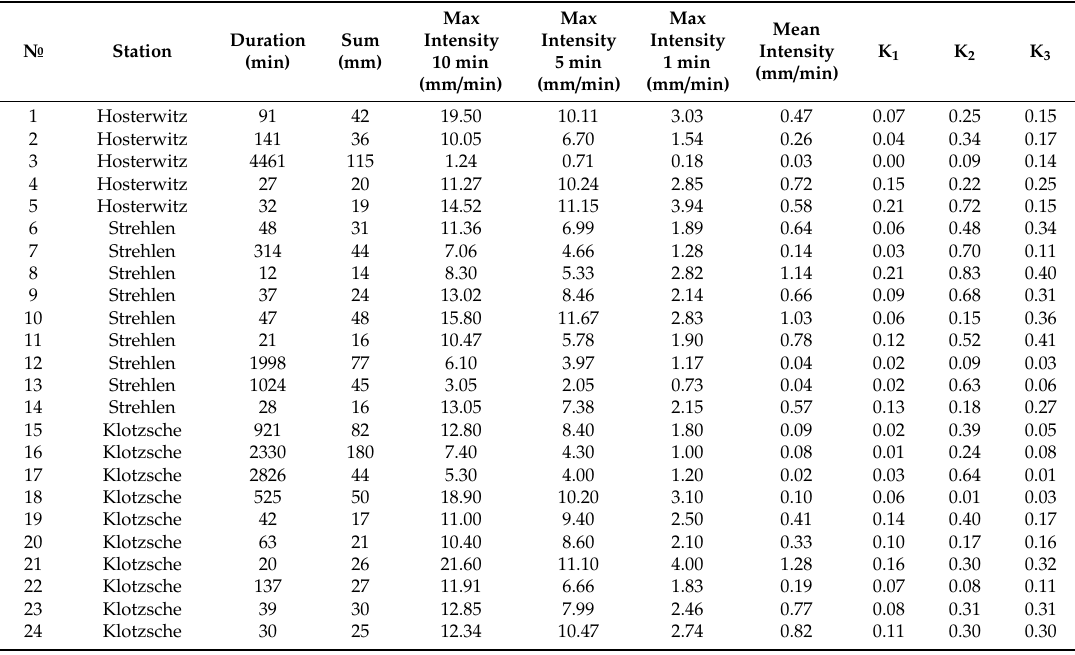
Table A1. Observed and designed rain